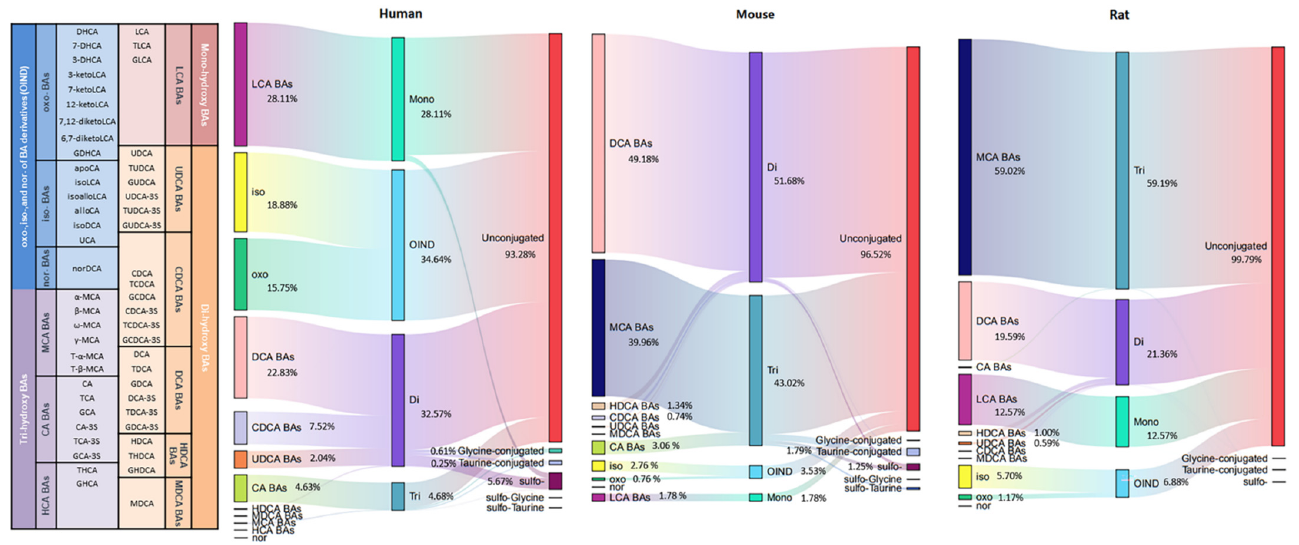
Figure 4. Sankey diagram of different bile acid concentration distribution in humans, rats, and mice.